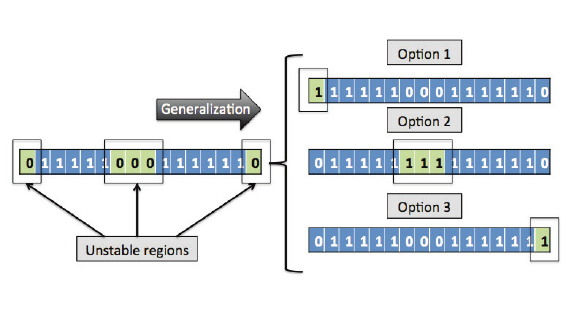
Fig. 4. Generalization